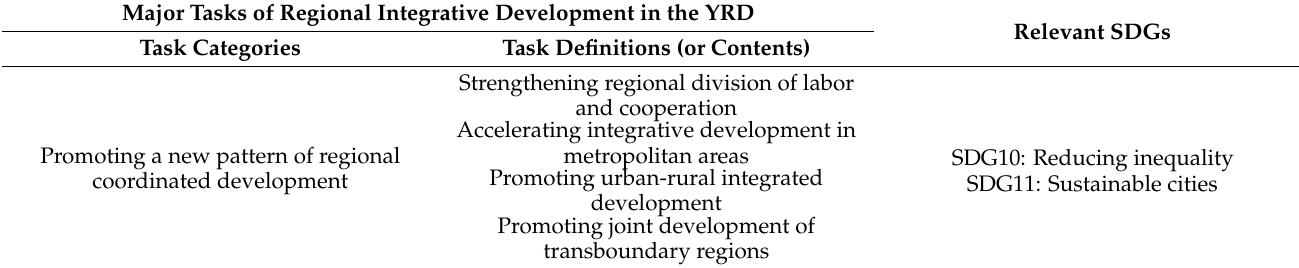
Table 1. The association between 17 SDGs and major tasks of regional integrative development in the